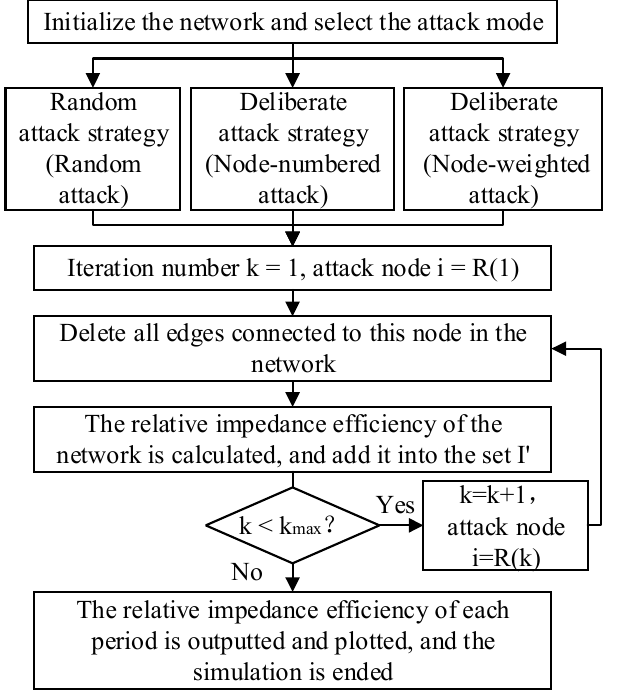
Figure 3. The invulnerability simulation process of attacking